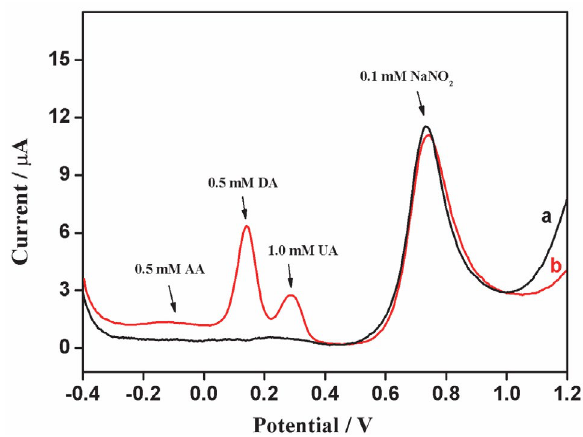
Fig 10. DPVs of the PEDOT/Fe 3 O 4 -CNCC/GCE in the absence (a) and presence (b) of 0.5 mM AA, 0.5 mM DA, 1.0 mM UA, 1